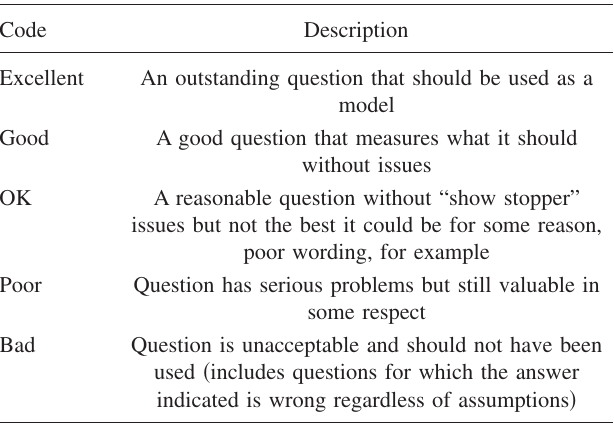
TABLE III. Descriptions of codes used to assign an overall rat- ing to each physics and physical science item on the TAKS.